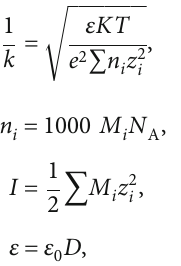
T 2 distribution of polymer-modi